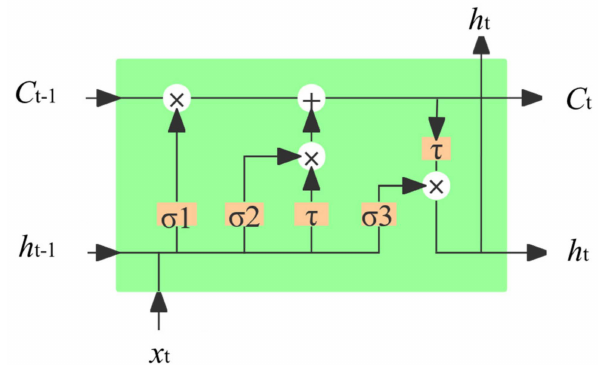
Figure 3. The structure of a LSTM cell.